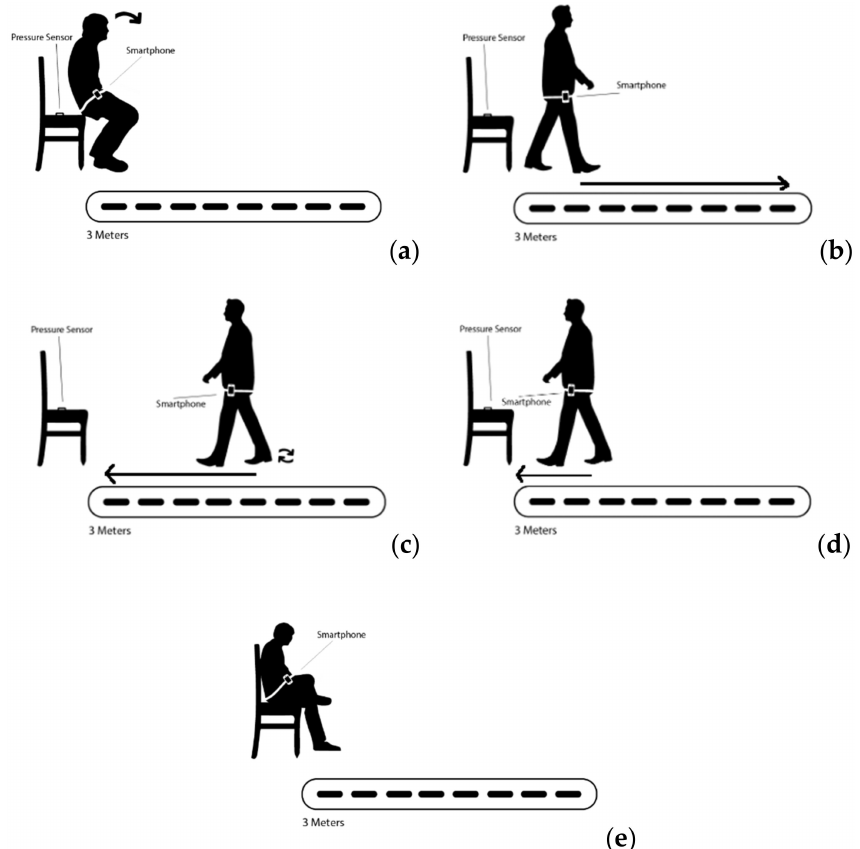
Figure 1. Timed-Up and Go test execution phases. ( a ) the individual sits in a chair; ( b ) the individual walks 3 meters; ( c ) the individual reverses the gait; ( d ) the individual walks back; ( e ) the individual sits back in the